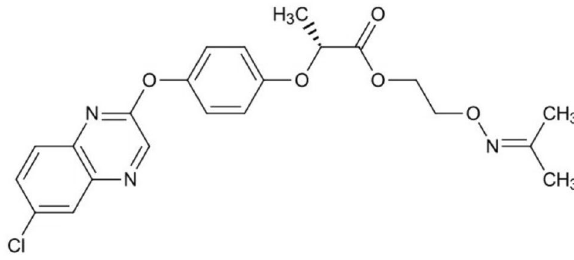
Figure 1. Chemical structure of propaquizafop.